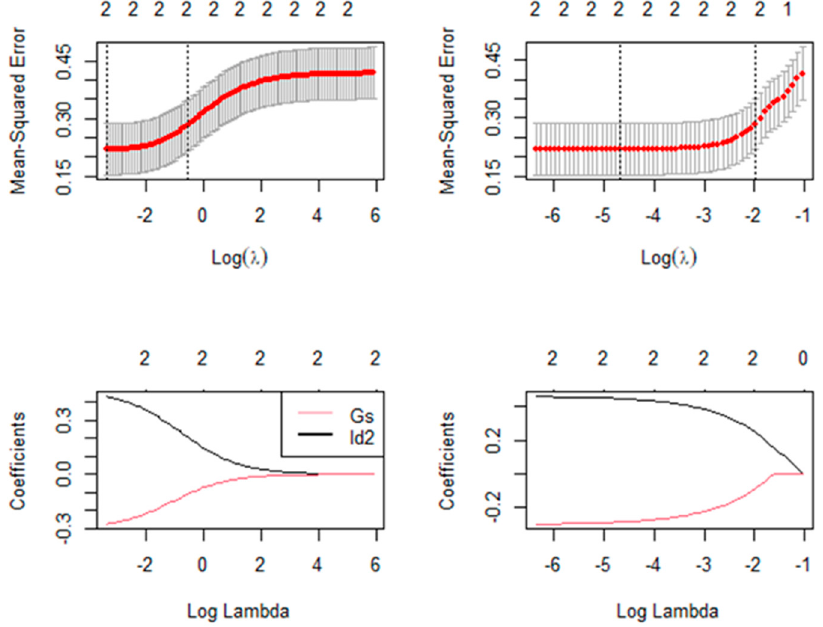
Figure 9. Ridge and Lasso plots as a function of log ( λ ).